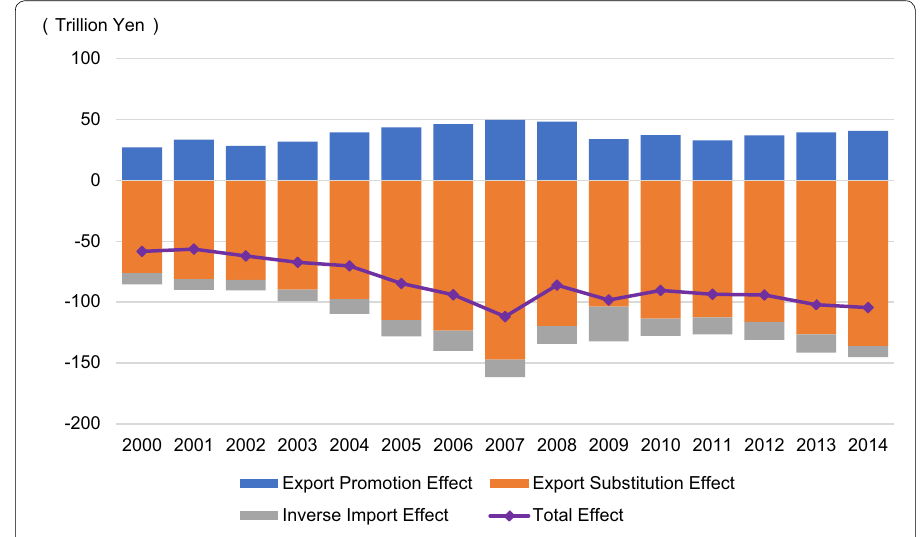
Fig. 3 Impact on the domestic production of Japan (2000–2014). Remark: export promotion effect is case A. Source : calculated by